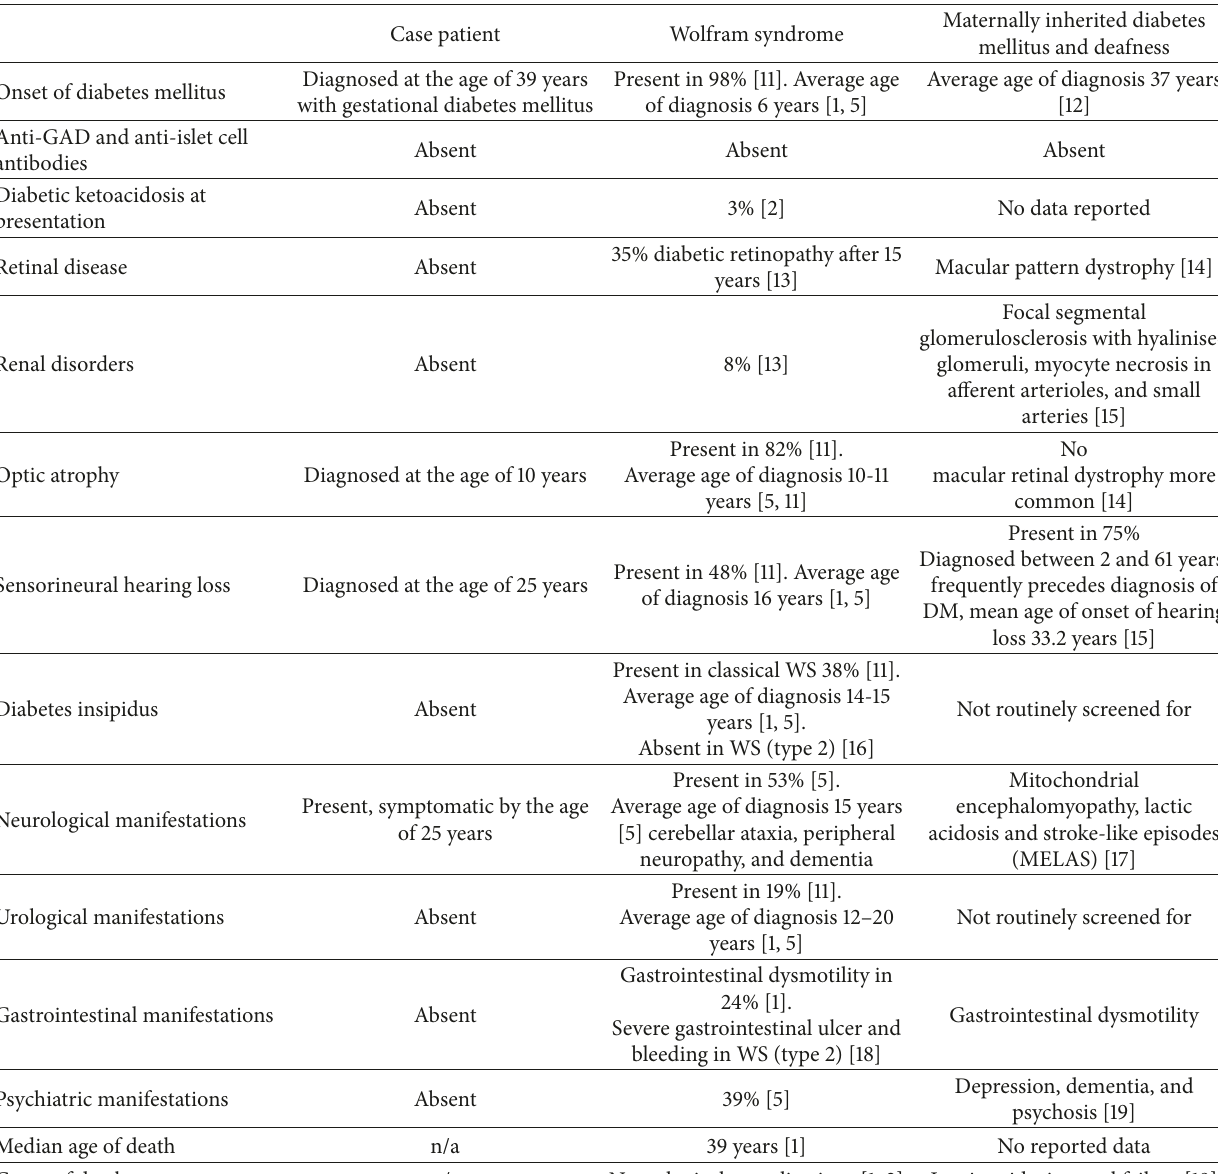
Table 1: Comparison of our patient to WS and